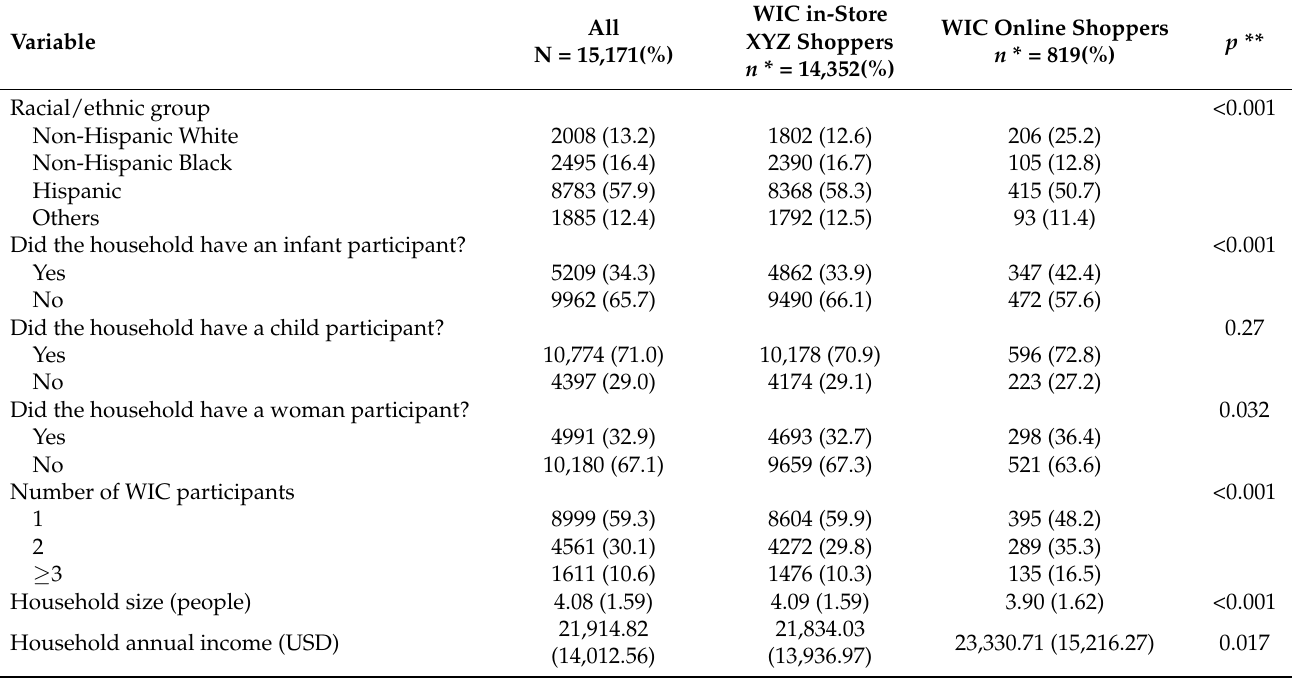
Table 1. Descriptive statistics of the socio-demographics between WIC XYZ in-store shoppers and online